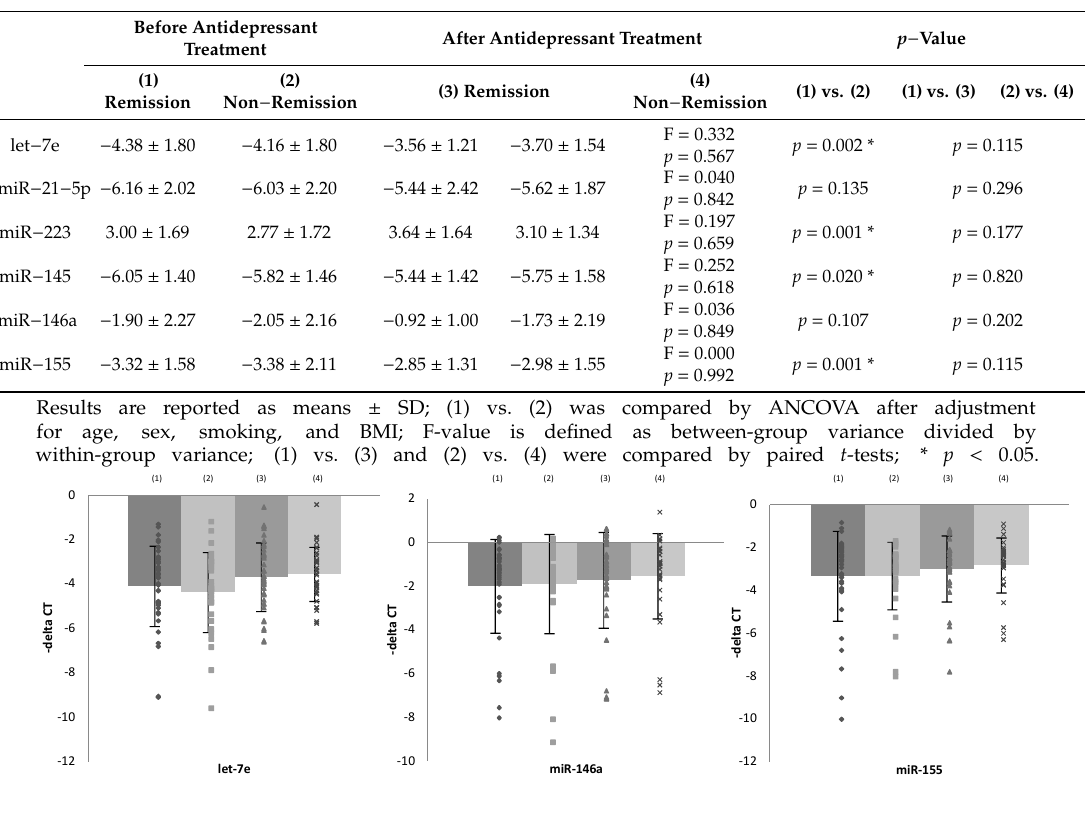
Table 5. Correlations between HAMD-17 scores and expression of microRNA in monocytes as determined by multiple linear regression analysis.